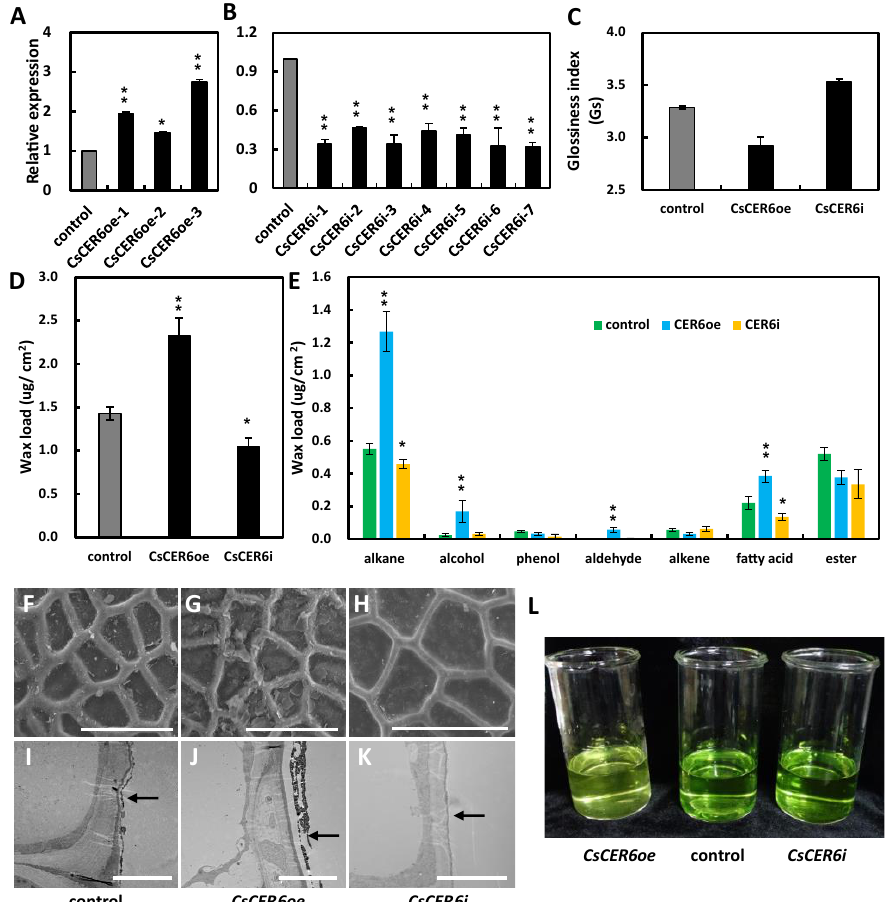
Figure 4. CsCER6 regulates cucumber wax content in cucumber. ( A , B ) qRT-PCR analyses of CsCER6 in control, various CsCER6 overexpressing ( A ) and CsCER6 -RNAi lines ( B ). ( C ) Fruit glossiness value of 9 DAA fruit in control, CsCER6i , and CsCER6oe lines. ( D ) The cuticular wax load of 9 DAA fruit in control, CsCER6oe , and CsCER6i lines. ( E ) The cuticular wax composition of 9 DAA fruit in control, CsCER6oe and CsCER6i lines. The data of columns are the mean ± standard deviation. ( F – H ) Epicuticular wax crystal formation on 9 DAA fruit surfaces of control ( F ), CsCER6oe ( G ) and CsCER6i plants by SEM. ( I – K ) The wax layer on 9 DAA fruit surfaces of control ( I ), CsCER6oe ( J ), and CsCER6i ( K ) plants by TEM. The arrows indicate the wax layer. ( L ) Chlorophyll permeation test of different transgenic CsCER6 cucumber lines. * means p < 0.05, ** means p < 0.01, Student’s t -test. Scale bars = 40 µ m in ( F – H ); 1 µ m in ( I – K